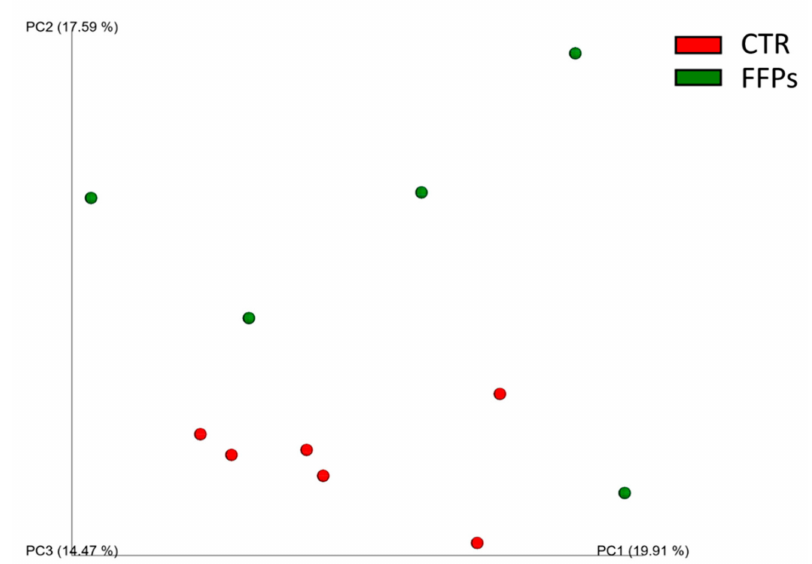
Figure 3. Principal Component Analysis (PCoA) of unweighted UniFrac beta-diversity of gut microbial communities from stools collected at the end of the experimental period. The first three principal coordinates(PC)fromthePCoAareplotted. Symbolsrepresentdatafromindividualpiglets, color-coded by the metadata